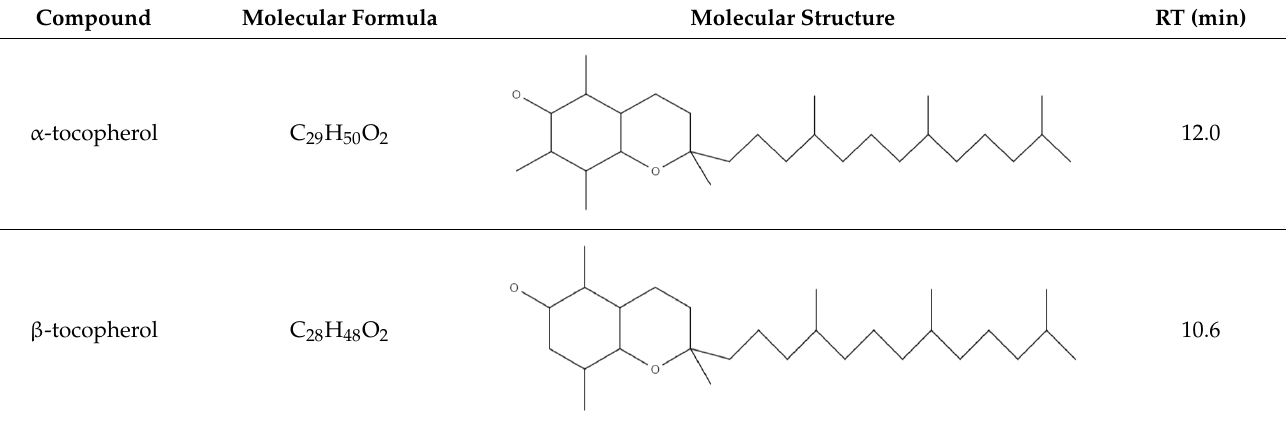
Table 6. Mean values ± SD (mg per kg of walnut seed oil) of samples.